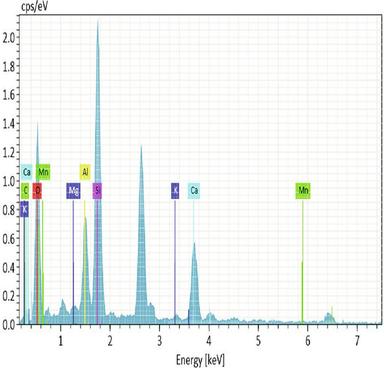
EDS of Sample 1.